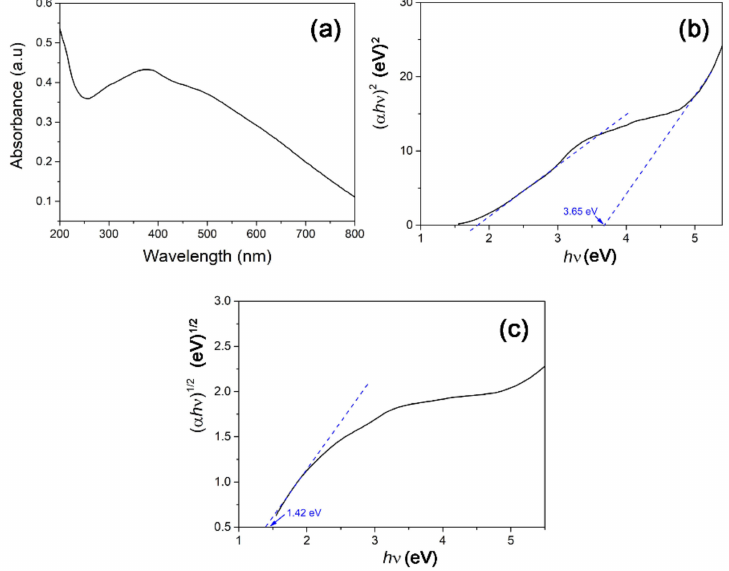
Figure 5. ( a ) UV–Vis absorption spectrum of M. calabura derived CuO nanoparticles and the corre- sponding Tauc plot for ( b ) direct and ( c ) indirect band